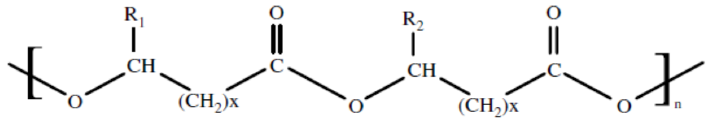
Figure 2. General structure of polyhydroxyalkanoates (R 1 /R 2 = alkyl groups C 1 –C 13 , X = 4, n = 100–30,000) [76].